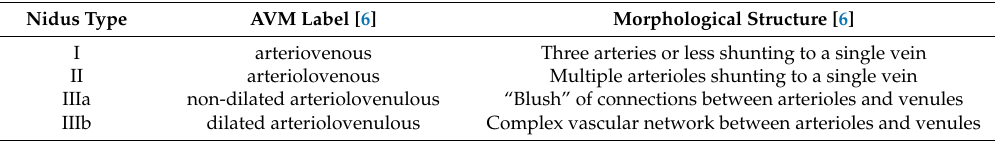
Table 1. Cho–Do classification system of arteriovenous malformations based on nidus morphology [7].